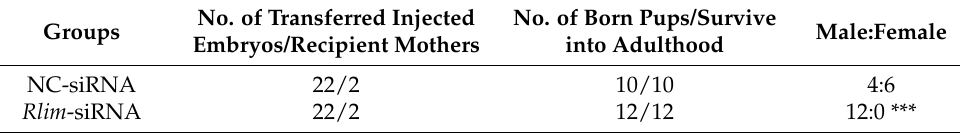
Table 3. Effects of RNA interference of Rlim in mouse embryos on offspring sex ratio.